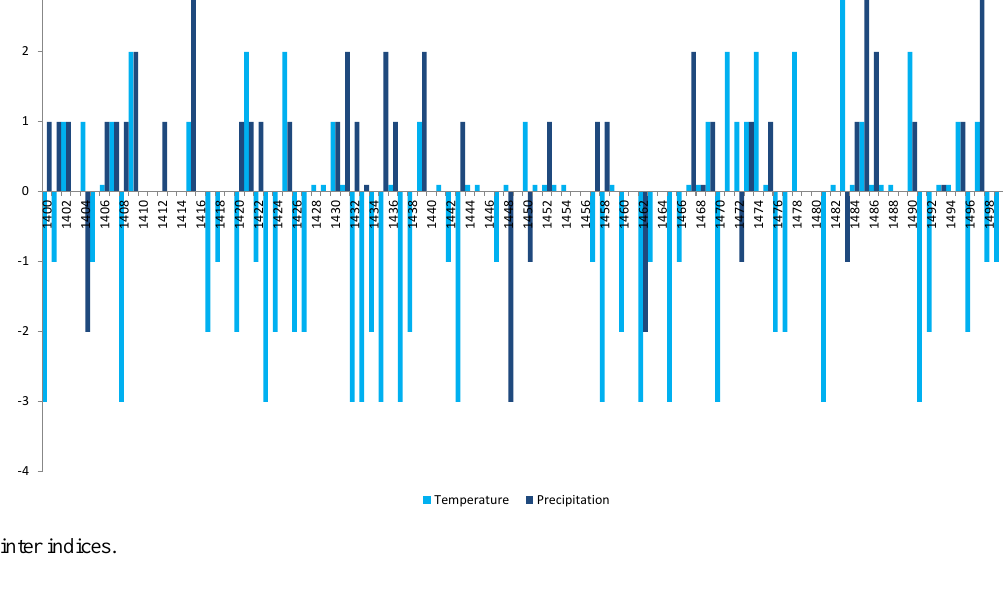
Figure 4. Winter indices.